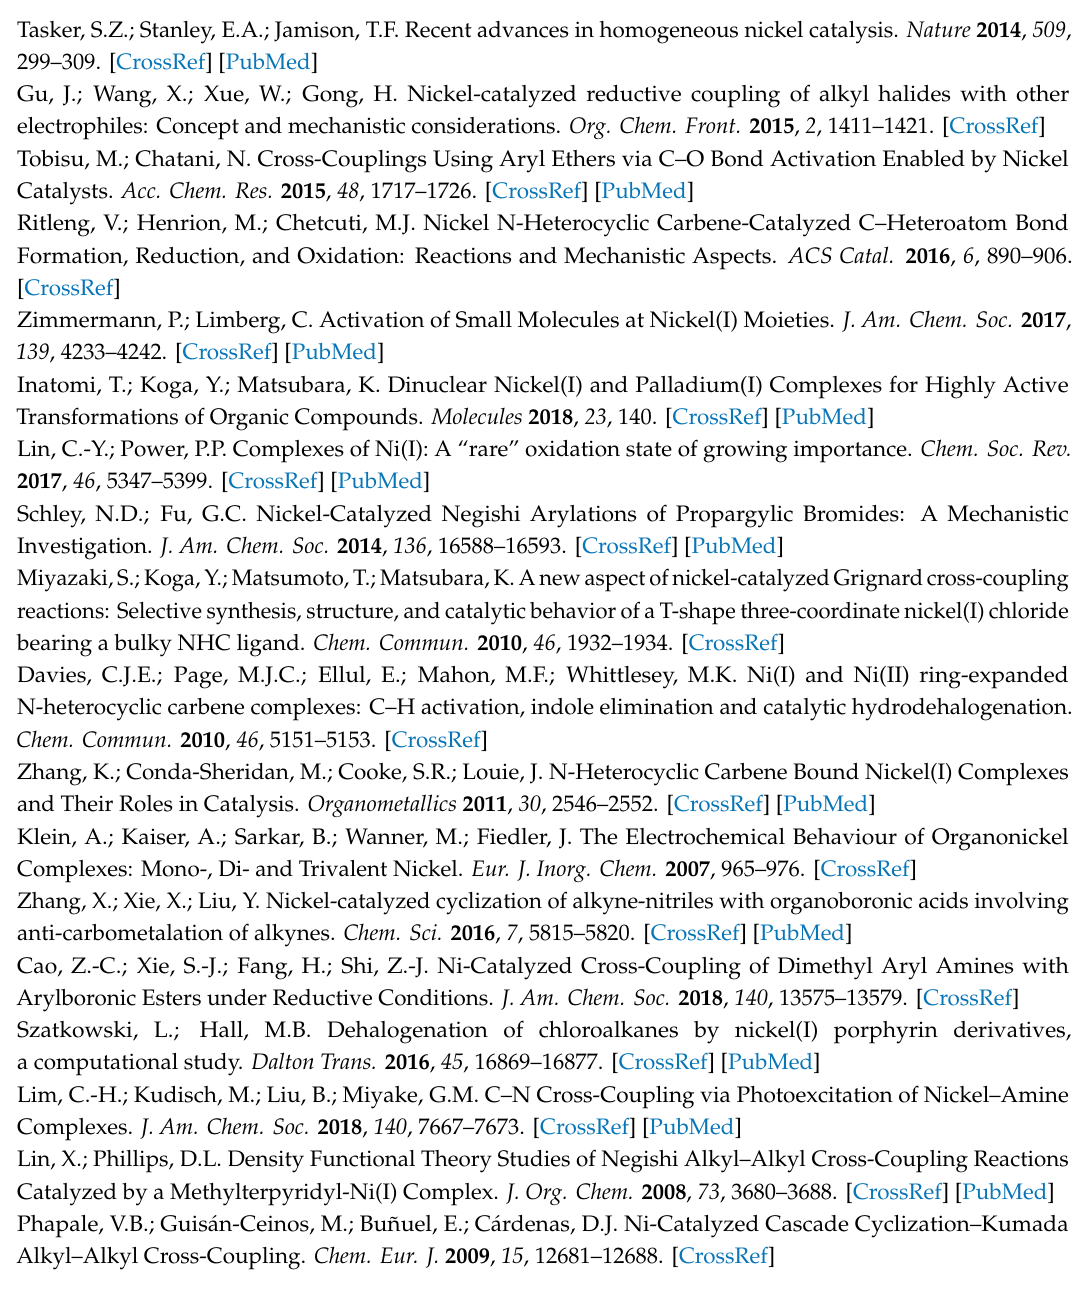
Supplementary Materials: The supplementary materials are available online. Figure S1–S8: NMR spectra for the complexes, Figure S9: χ mol T vs T plot, Figure S10: ESR spectrum, Figure S11–S12: Packing views of the complexes (expanded views), details of the Kumada coupling reactions including NMR spectra of